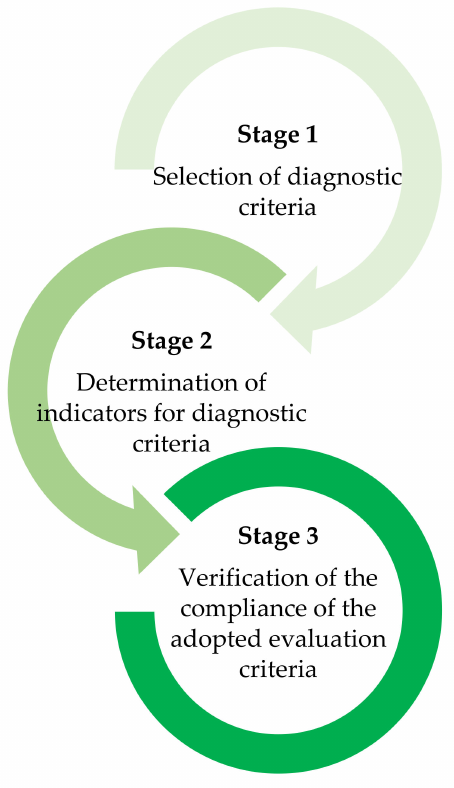
Figure 4. Research plan. Source: own